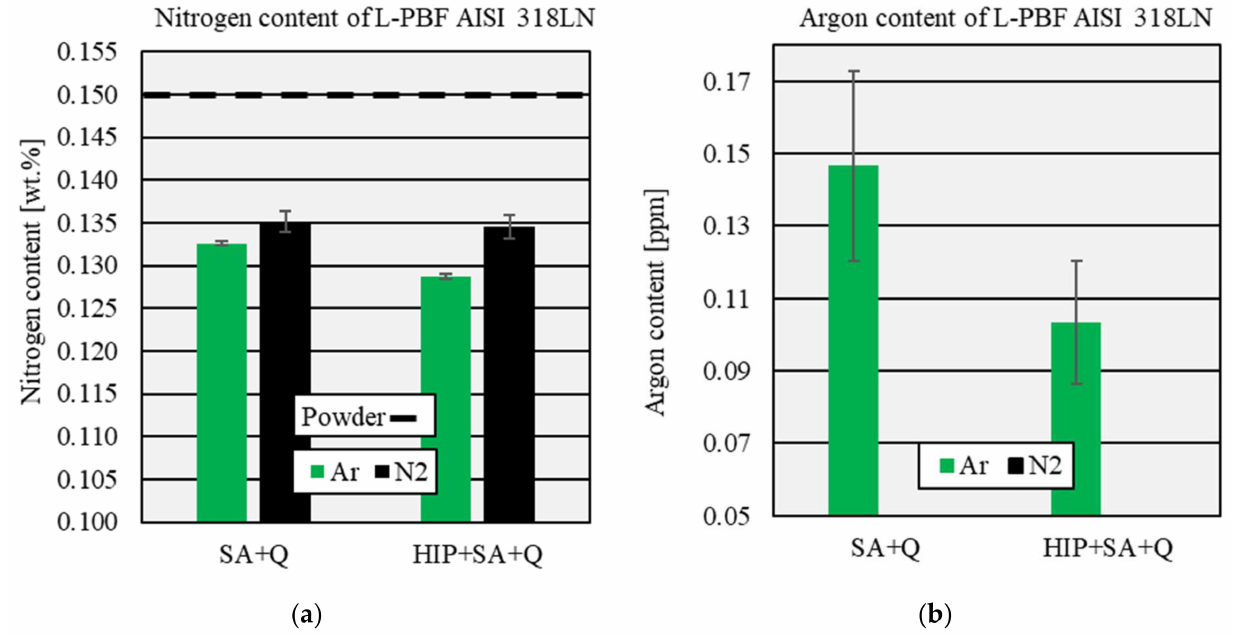
Figure 14. ( a ) Nitrogen and ( b ) argon content of L-PBF-processed AISI 318LN under an argon and nitrogen